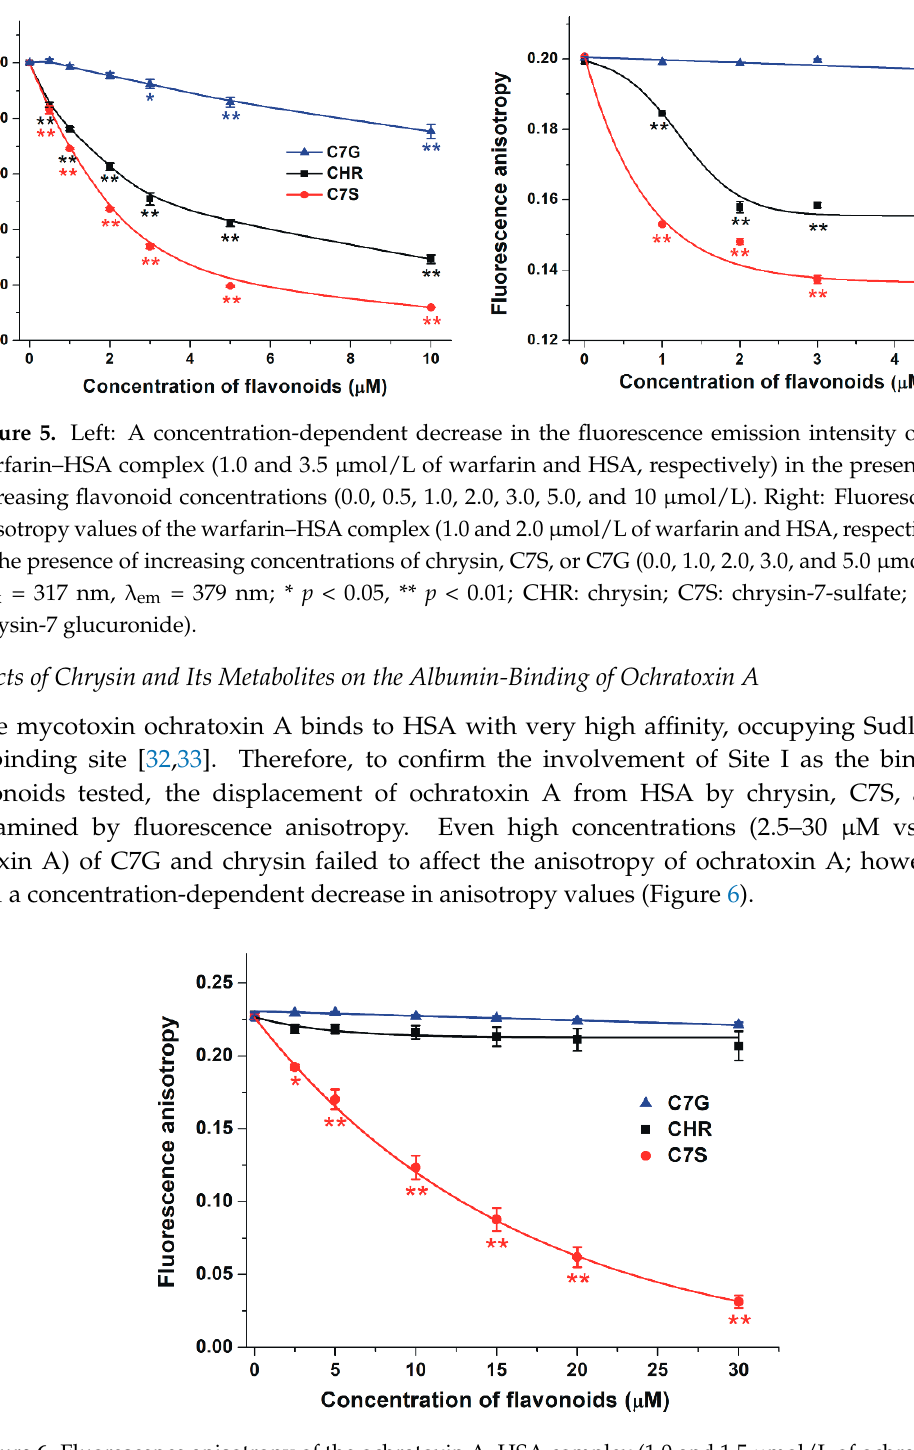
Figure 6. Fluorescence anisotropy of the ochratoxin A–HSA complex (1.0 and 1.5 µmol/L of ochratoxin A and HSA, respectively) in the presence of increasing concentrations of flavonoids (0.0, 2.5, 5.0, 10, 15, 20, and 30 µmol/L) in PBS (pH 7.4; λ ex = 393 nm; λ em = 446 nm; * p < 0.05, ** p < 0.01; CHR: chrysin; C7S: chrysin-7-sulfate; C7G: chrysin-7 glucuronide).